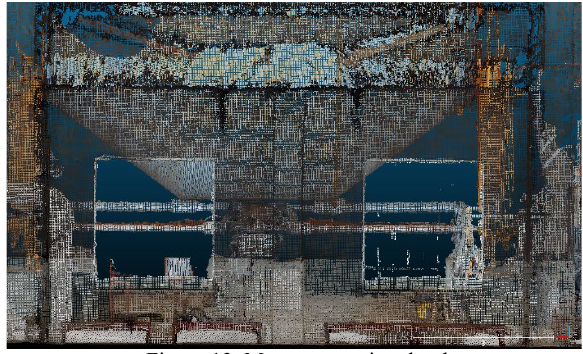
Figure 13. Matterport point cloud In order to be sure that our data are correct, i.e. without the scale distortion, control targets were placed on the walls of the Hoist Engine house. Using of CloudCompare software eight distances between these targets were measured on Matterport point cloud